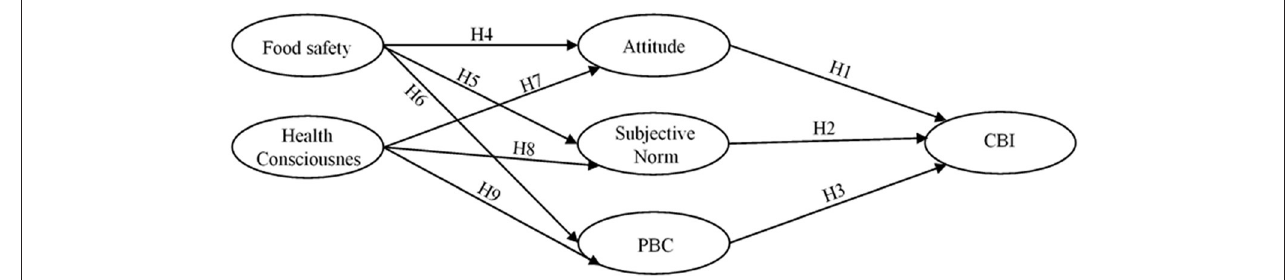
FIGURE 1 | Hypothesized